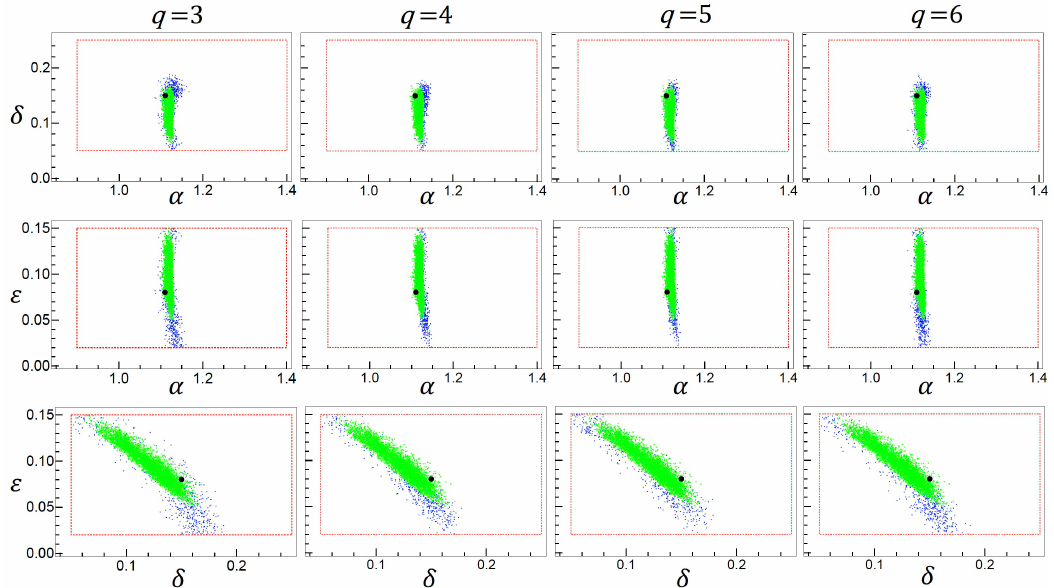
Figure 9: 2D projections of the true posterior for model (13) (green) compared against ABC posteriors (blue) from ENCA using, from left to right columns, three, four, five and six summary statistics ( q = 3,4,5,6). The dashed boxes represent the ABC priors, while the black dots represent the true values of the parameters used to generate the synthetic data set.